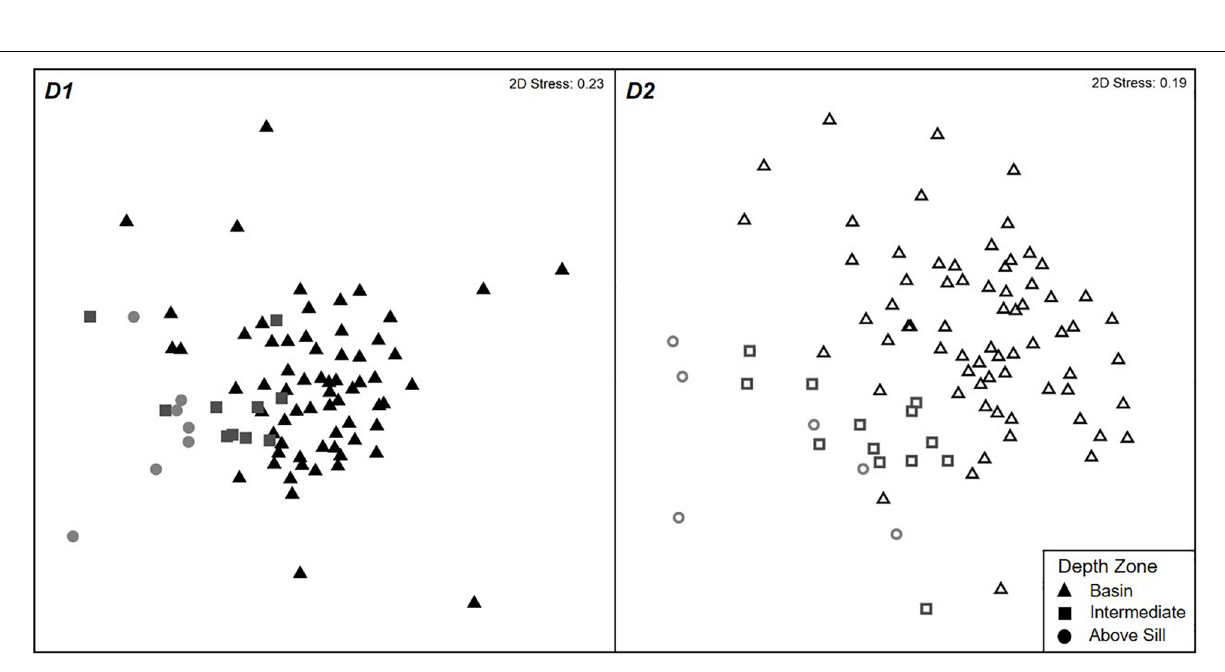
FIGURE 5 | Non-metric MDS ordination plots visualizing the Sørensen resemblances of the megafauna presence-absence data at different depth zones between Dive 1 (stress = 0.23; left) and Dive 2 (stress = 0.19; right). The distance between the points relates to the similarity of community composition at each depth, whereby the closer the points the more similar the